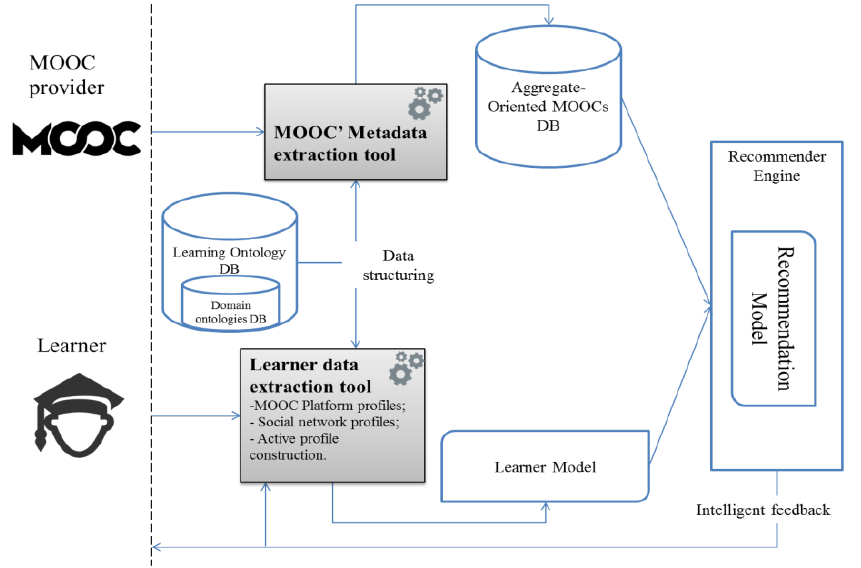
Fig. 3. Functional architecture of personalized suggestions in